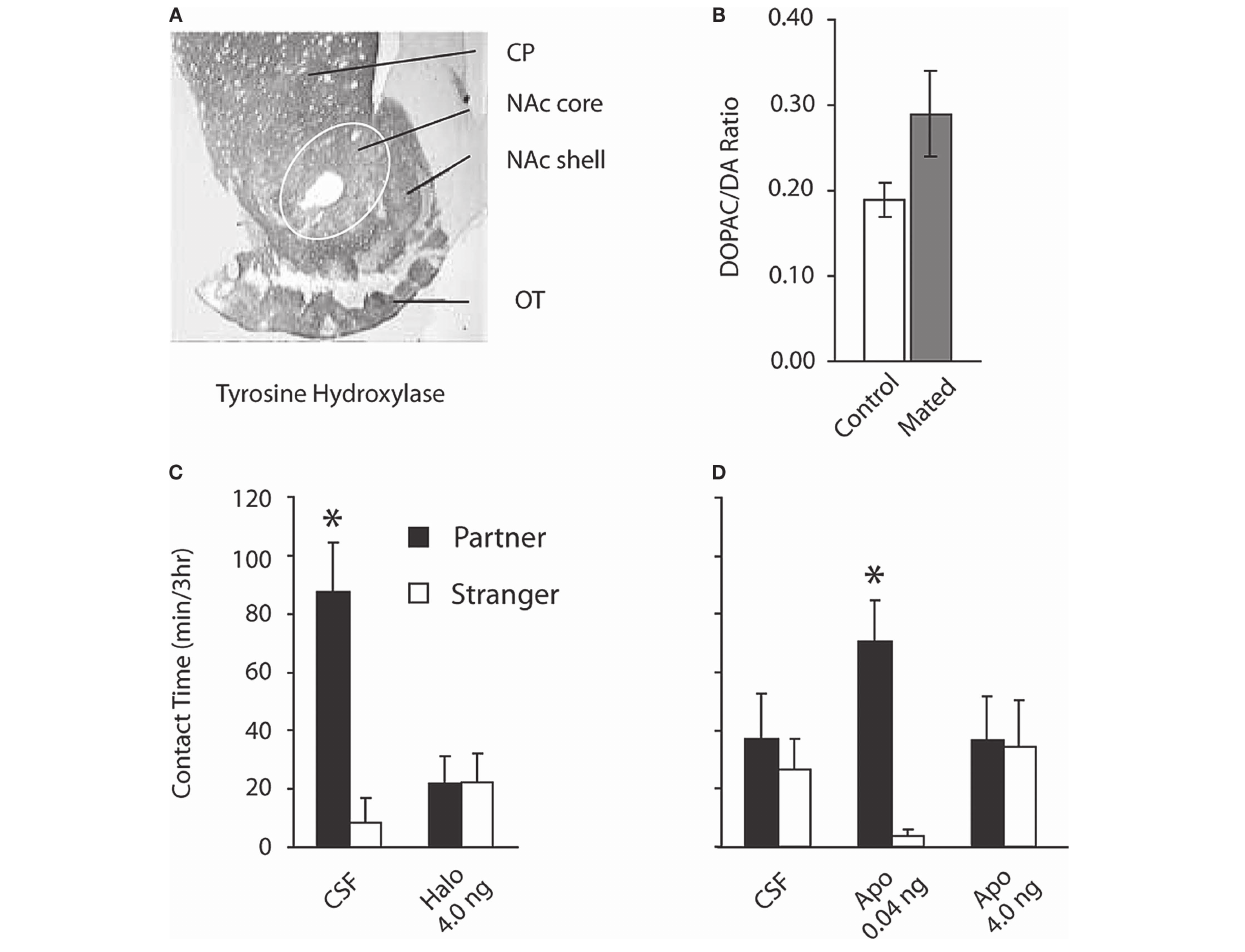
FIGURE 2 | Dopamine regulation of pair bond formation. (A) Coronal section showing tyrosine hydroxylase immunocytochemical labeling of dorsal and ventral striatum from an adult male prairie vole. CP = caudate putamen, NAc = nucleus accumbens NAc shell, OT = olfactory tuberacle. (B) Dopamine turnover as indicated by increased concentration of the dopamine metabolite DOPAC and decreased concentration of DA from micro-dissected of NAc tissue,